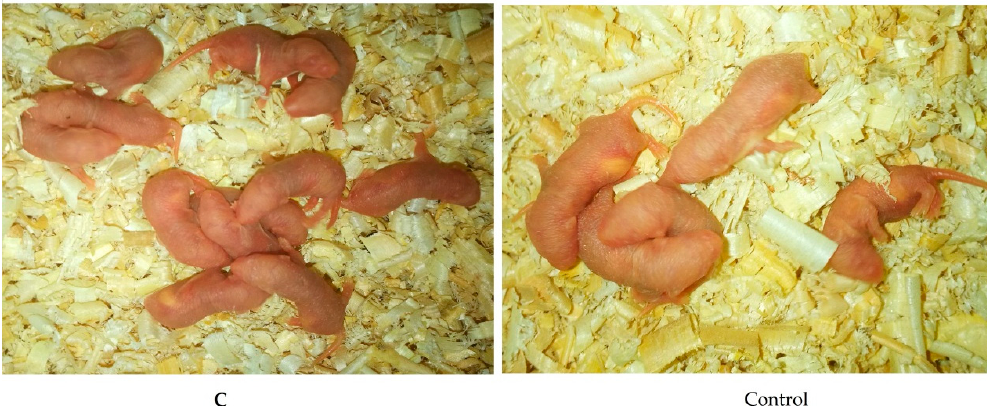
Figure 4. Representative images of newborn mice. ( A ) Melatonin was given 14 days before mating (vaginal plugs were detected); ( B ) Melatonin was given from the mating (vaginal plugs were detected) to the delivery; ( C ) Melatonin was given from 14 days before mating (vaginal plugs were detected) to the delivery; ( Control ) Without any treatment.